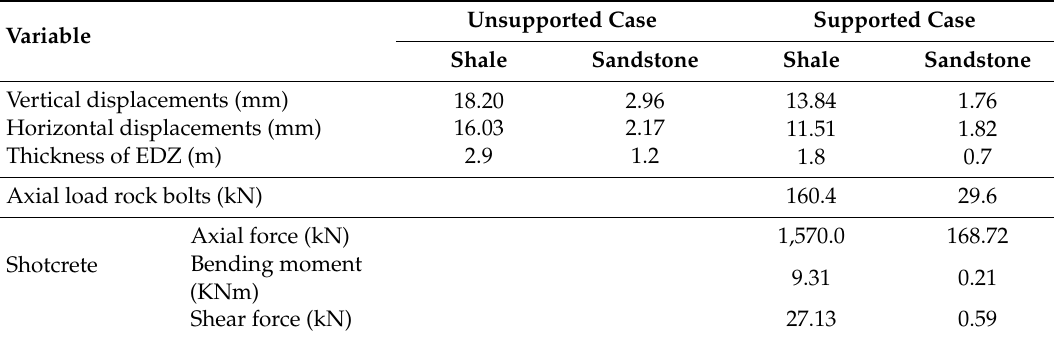
Table 8. Numerical simulation results in the junction zone.